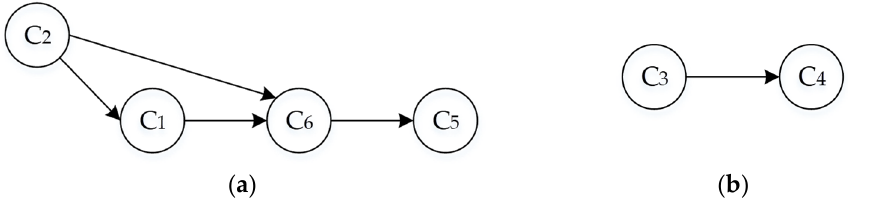
Figure 26. ( a ) Preliminary solution node conflict network 1; ( b ) Preliminary solution node conflict network 2.